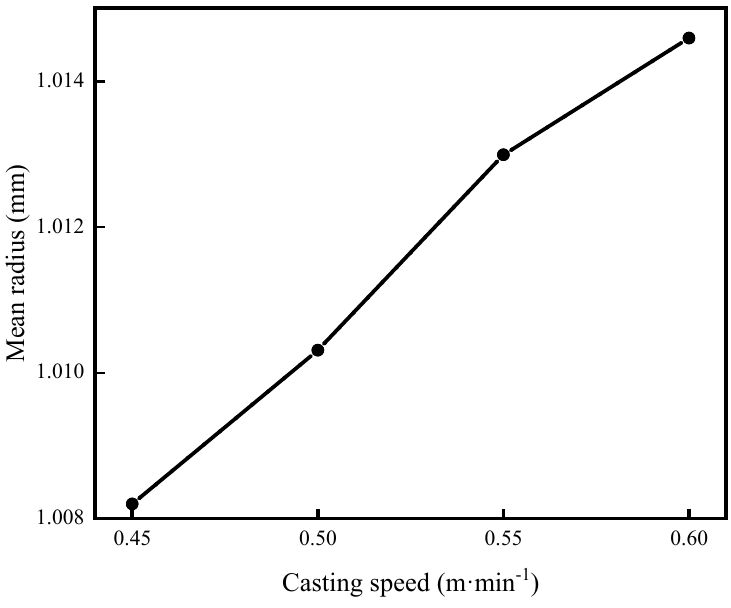
Figure 8. The average grain size of the slab with different casting speeds.